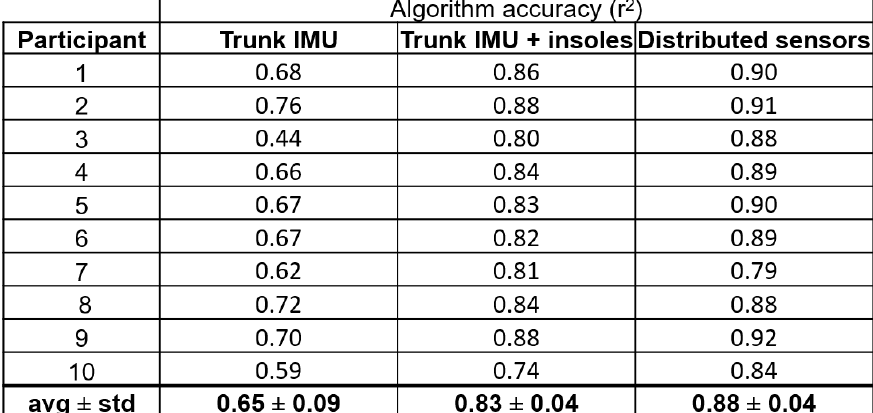
Figure A5. Algorithm accuracies when estimating the lumbar lateral bending moment. Shown are the participant-specific and average (avg) accuracy results from three different subsets of idealized wearable sensors: trunk IMU, trunk IMU and pressure insoles, and all distributed sensors. Accuracy is reported as the coefficient of determination (r 2 ) across all time samples for a given participant.